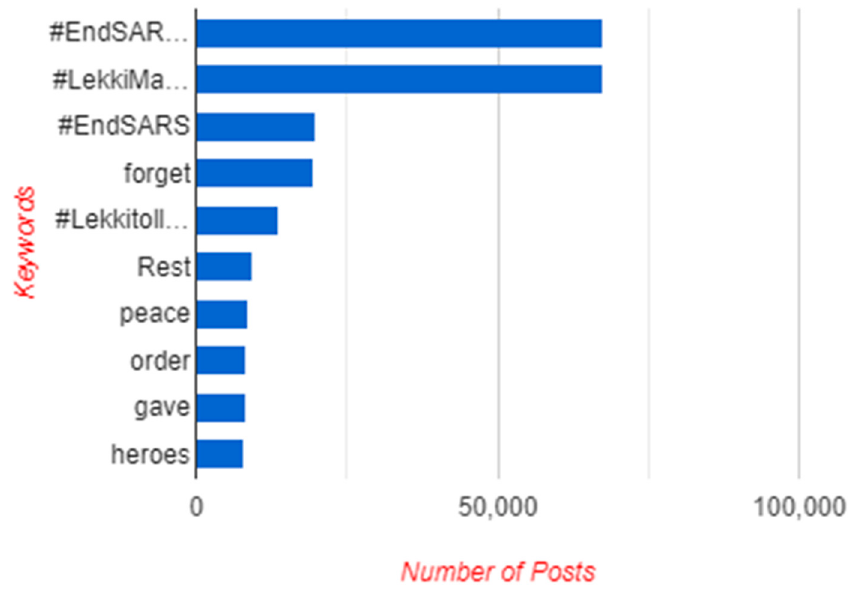
Figure 2. Keywords from tweets and retweets. Table 2 indicates that the bulk of the tweets were filled with “anger” and